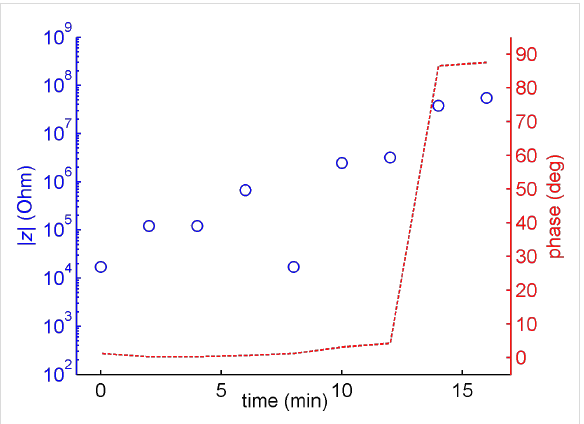
Figure 5: The kinetics of the lipid bilayer formation on a nanoporous alumina membrane is shown by measuring the impedance (blue) and the phase change (red) at 1 kHz across the nanoporous membrane over time.